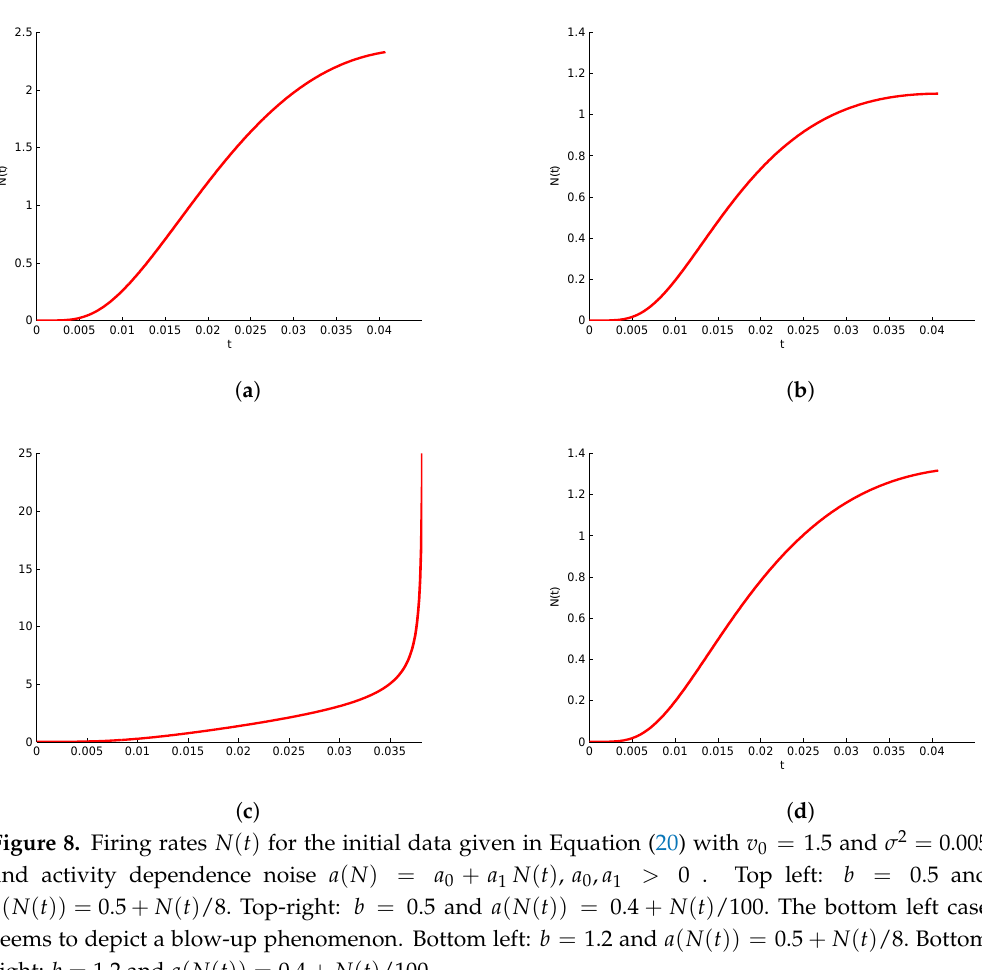
Figure 8. Firing rates N ( t ) for the initial data given in Equation (20) with v 0 = 1.5 and σ 2 = 0.005 and activity dependence noise a ( N ) = a 0 + a 1 N ( t ) , a 0 , a 1 > 0 . Top left: b = 0.5 and a ( N ( t )) = 0.5 + N ( t ) /8. Top-right: b = 0.5 and a ( N ( t )) = 0.4 + N ( t ) /100. The bottom left case seems to depict a blow-up phenomenon. Bottom left: b = 1.2 and a ( N ( t )) = 0.5 + N ( t ) /8. Bottom right: b = 1.2 and a ( N ( t )) = 0.4 + N ( t ) /100.